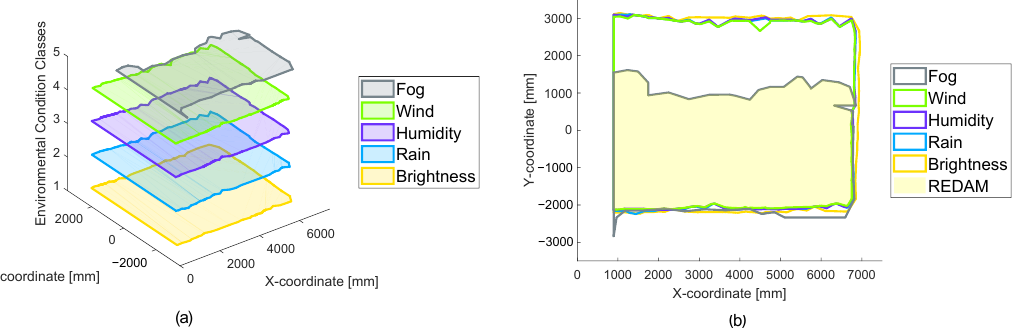
Figure 13. The creation of a real environment detection area matrix (REDAM) for the 2D LiDAR sensor system is shown. In part ( a ), the 3D visualization of the matrix is presented and in part ( b ) the view along the application axis with the resulting REDAM is